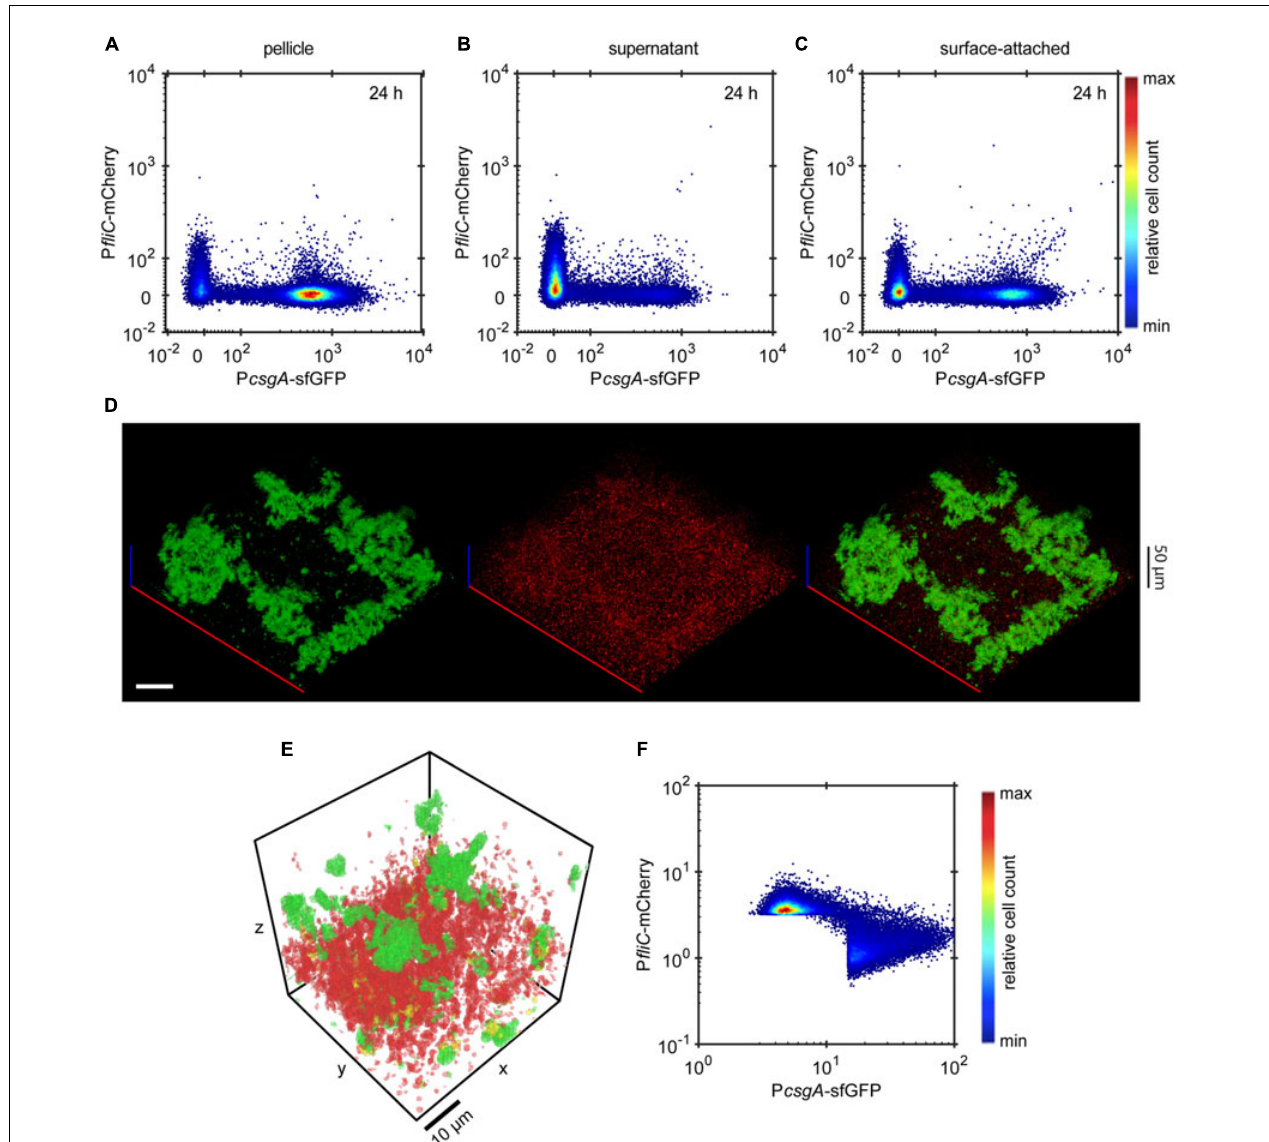
FIGURE 4 | Expression of curli fibers and flagella is mutually exclusive. (A − C) Scatter plots showing expression of P csgA -sfGFP and P fliC -mCherry in (A) pellicle, (B) supernatant and (C) surface-attached cells at 24 h as measured by flow cytometry. The color scale shows relative cell count from lowest (blue) to highest (red). (D) Confocal fluorescence microscopy images (maximum projection) showing the expression of P csgA -sfGFP (green) and P fliC -mCherry (red) in biofilms at 24 h. Scale bar, 40 µ m. (E,F) Quantification of relative expression of P csgA -sfGFP and P fliC -mCherry (see Material and Methods for details) in a region of the submerged biofilm shown in (D) , with a visual representation of the segmentation analysis (E) and relative expression in individual segments shown as a scatter plot (F) . In (E) green regions are P csgA -sfGFP-positive, red regions are P fliC -mCherry-positive and cells in yellow volumes express both fluorescence reporters. Note that sharp cutoffs in (F) correspond to the segmentation thresholds applied in image analysis (see Materials and Methods). The color scale shows relative cell count from lowest (blue) to highest